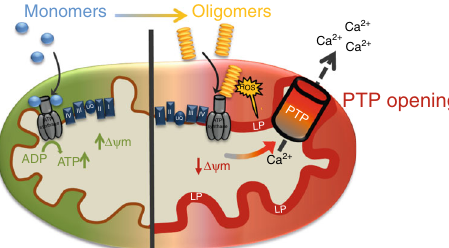
Fig. 7 Schematic diagram of oligomeric α -synuclein effects on mitochondria. Monomeric α -synuclein interacts with ATP synthase and improves the ef fi ciency of ATP synthesis. Oligomeric α -synuclein also interacts with ATP synthase but conversely, impairs respiration, and depolarises the mitochondria. Oligomers induce ROS production, leading to lipid peroxidation and oxidation of key mitochondrial proteins. Together, these oligomer-induced events open the mitochondrial permeability transition